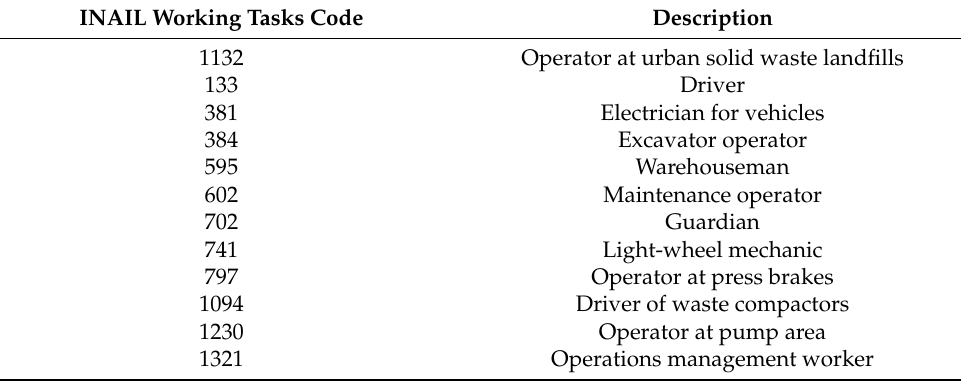
Table A2. INAIL working tasks in